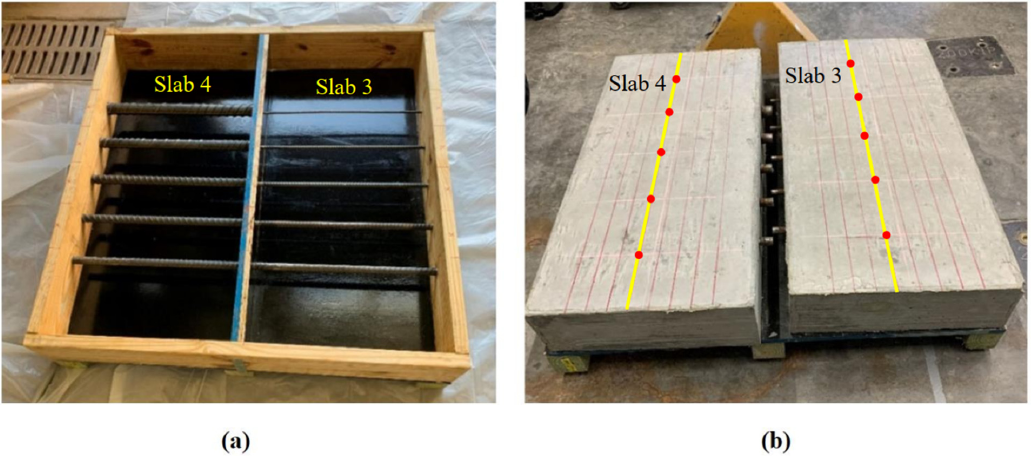
Figure 7. Slab 3 and Slab 4: ( a ) before and ( b ) after casting.